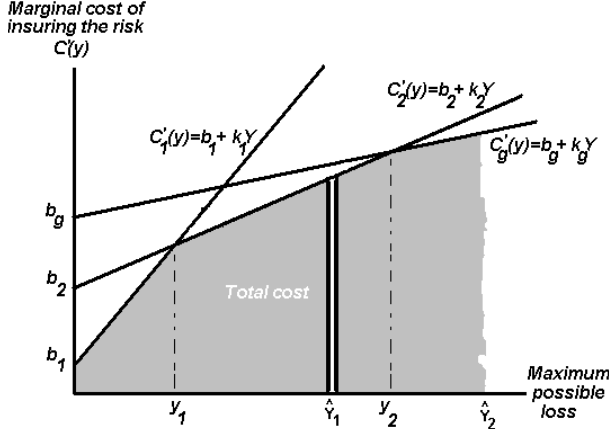
Fig. 9. Government intervention when risks have different maxi- mum possible losses.